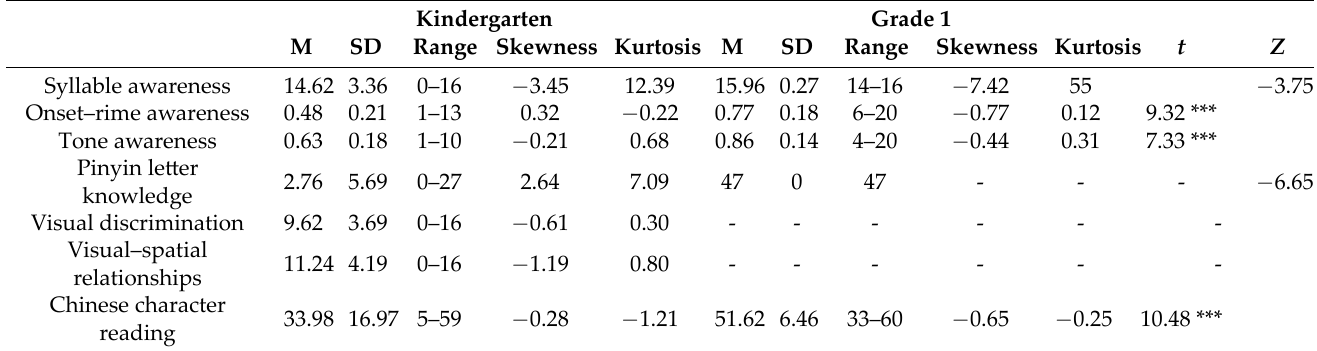
Table 1. Means, standard deviations, range, skewness and kurtosis of phonological awareness, Pinyin letter knowledge, visual perception skills, and Chinese character reading of 55 children in kindergarten and Grade 1 ( n = 55).